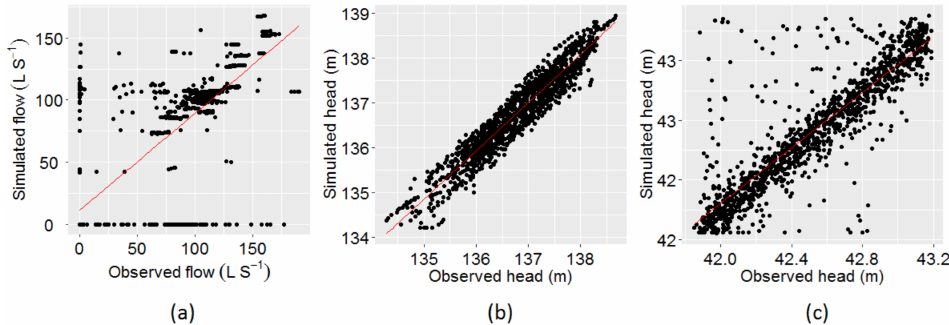
Figure 7. Plot of observed vs model-simulated values ( a ) flow at PS2 ( b ) head at Binnies tank and ( c ) head at Meningie tank.